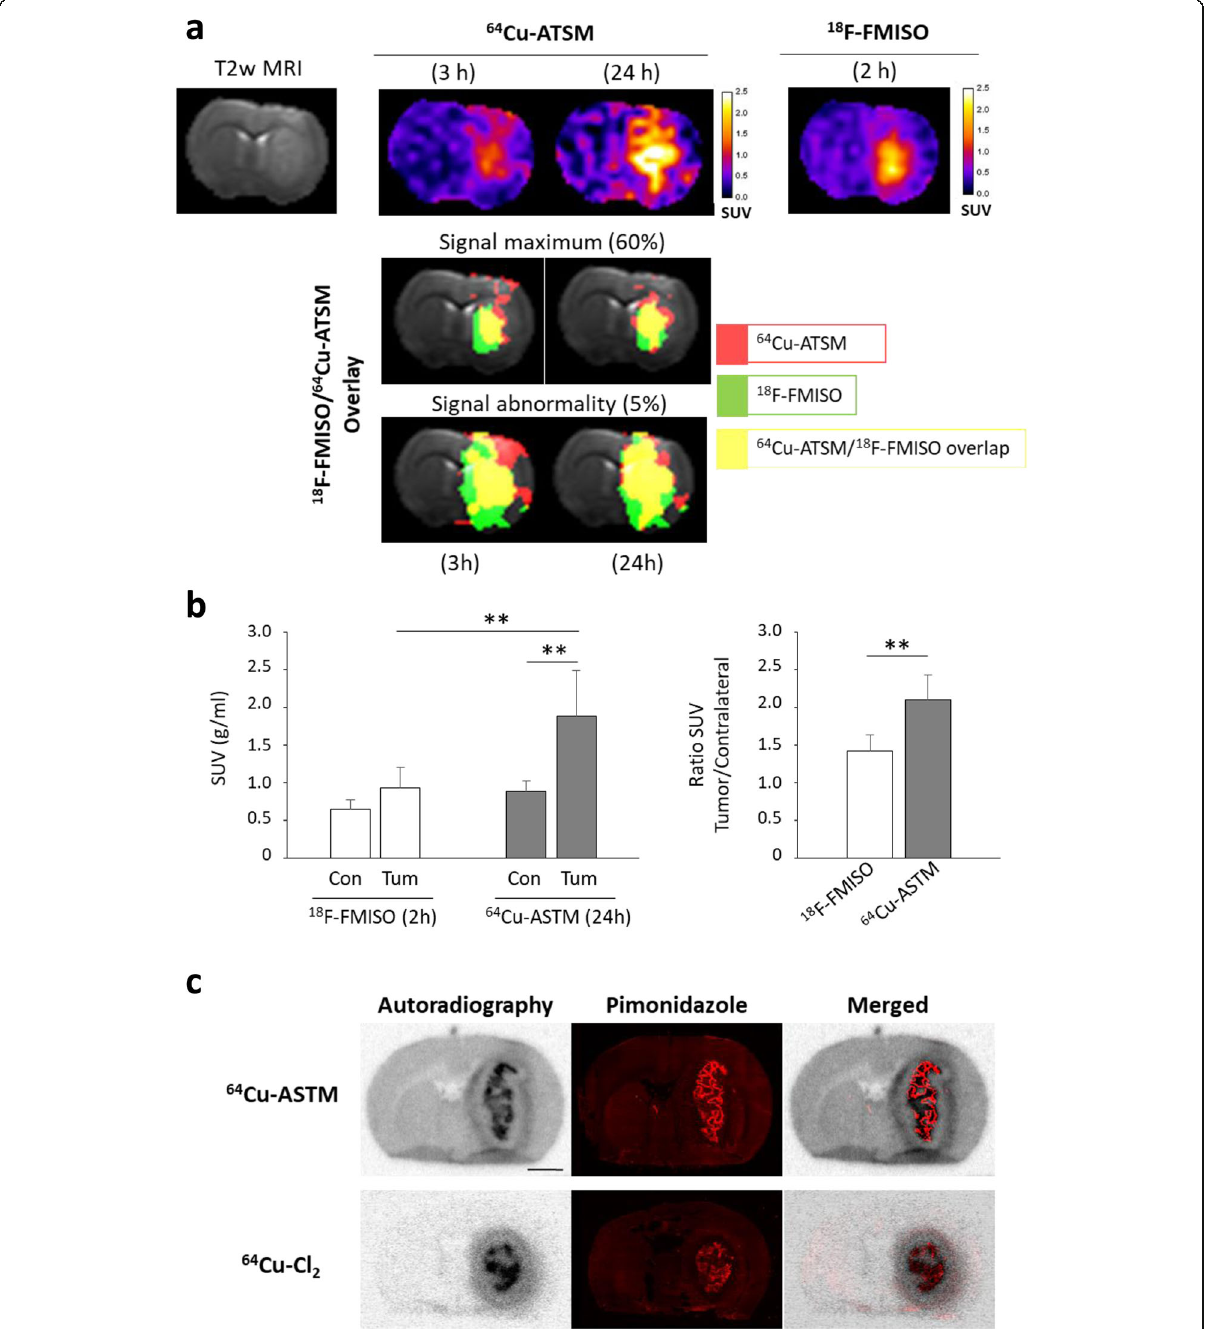
Fig. 3 Relationships between retention of 64 Cu-ATSM and 64 Cu-Cl 2 and hypoxia. a Co-registration of 18 F-FMISO PET signal (2 h post-injection) with 64 Cu-ATSM PET signal (3 h or 24 h post-injection). The overlaid images corresponds to 60% signal maximum or 5% signal abnormality for 64 Cu- ATSM (red), 18 F-FMISO (green), or 64 Cu-ATSM/ 18 F-FMISO merged (yellow). b 18 F-FMISO and 64 Cu-ATSM uptake were evaluated at 2 h and 24 h after radiotracer injection, respectively. Quantification of 64 Cu-ATSM and 18 F-FMISO uptake from ipsilateral (tumor) and contralateral (healthy brain) SUVs (left part) or ratio between tumor and contralateral SUVs (right part) at the different imaging points. Mean ± SD, n = 5 rats for 18 F-FMISO and n = 3 rats for 64 Cu-ATSM. Tukey ’ s HSD test after significant two-ways ANOVA (radiotracer and ROI factors): ** p < 0.01. c From same coronal rat brain sections performed 24 h after 64 Cu-ATSM or 64 Cu-Cl 2 injection, autoradiography and pimonidazole immunostaining were done to evaluate overlapping of these two labeling. Scale bar = 250 μ